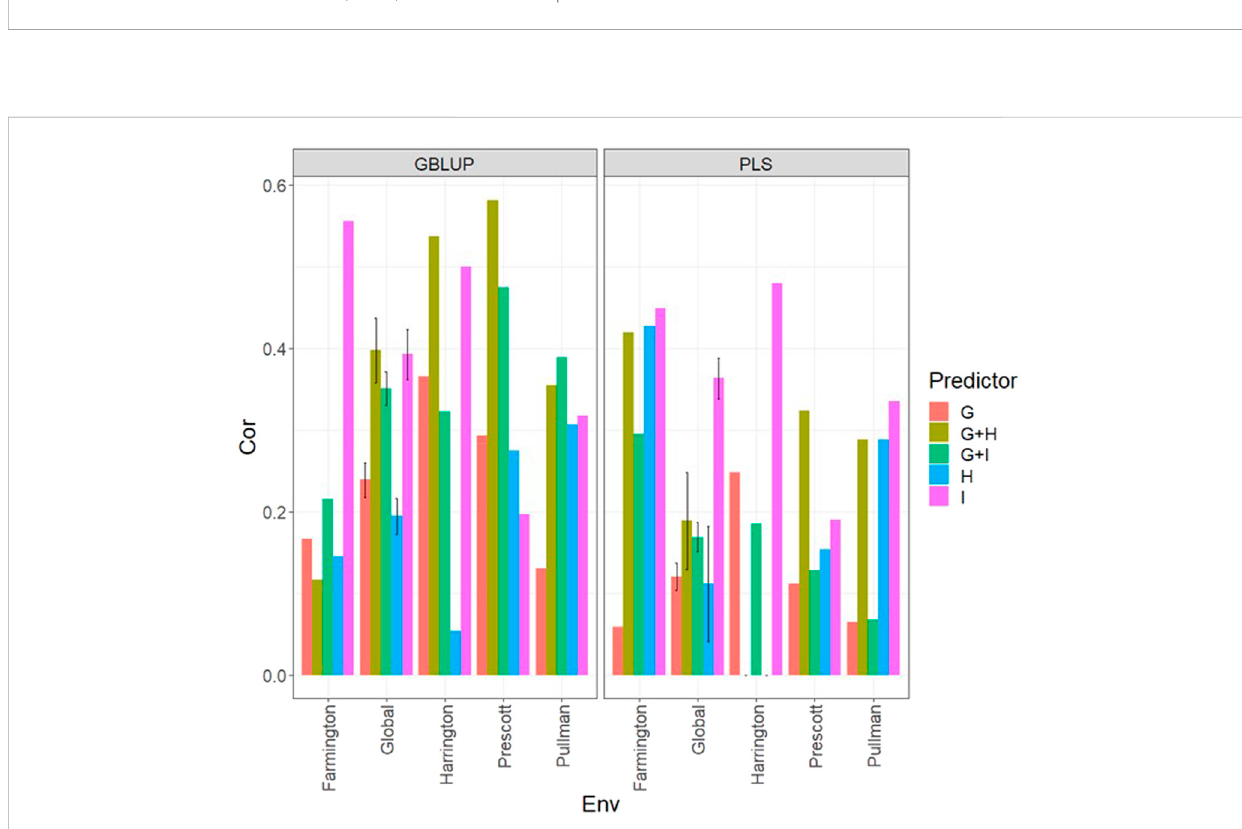
FIGURE 7 Dataset 3 (year 2021). Pearson´s correlation (Cor) and their corresponding Standard Error (SE) for each location and across location (Global) under tested lines in untested environments (LOEO) for nine evaluated predictors under a GBLUP and PLS models.